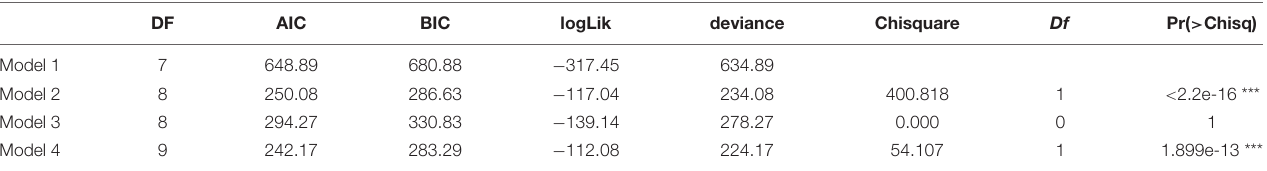
TABLE 3 | The comparison between different mixed linear regression models with post-larval NPS as the dependent variable and Year and Ontogenic stage as fixed factors and Otolith and Ontogenic stage as grouping variables. DF AIC BIC logLik